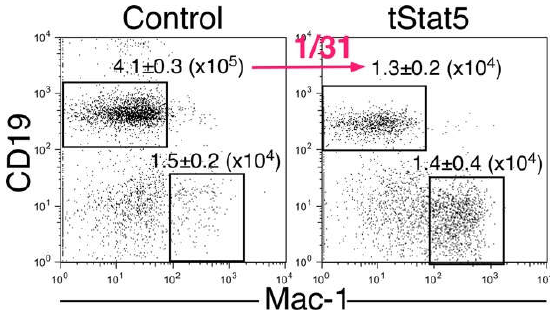
Figure 5. Truncated STAT5 (tSTAT5) had inhibitory functions in B-cell development. KLS cells from WT mice were infected with control or tSTAT5 retroviruses. These cells were injected into 400 rad-irradiated RAG2 − / − mice. Recipient-derived cells in the spleens of host mice were analyzed at 5 weeks after injection. The numbers in the plots were the means of B and myeloid cell numbers from three